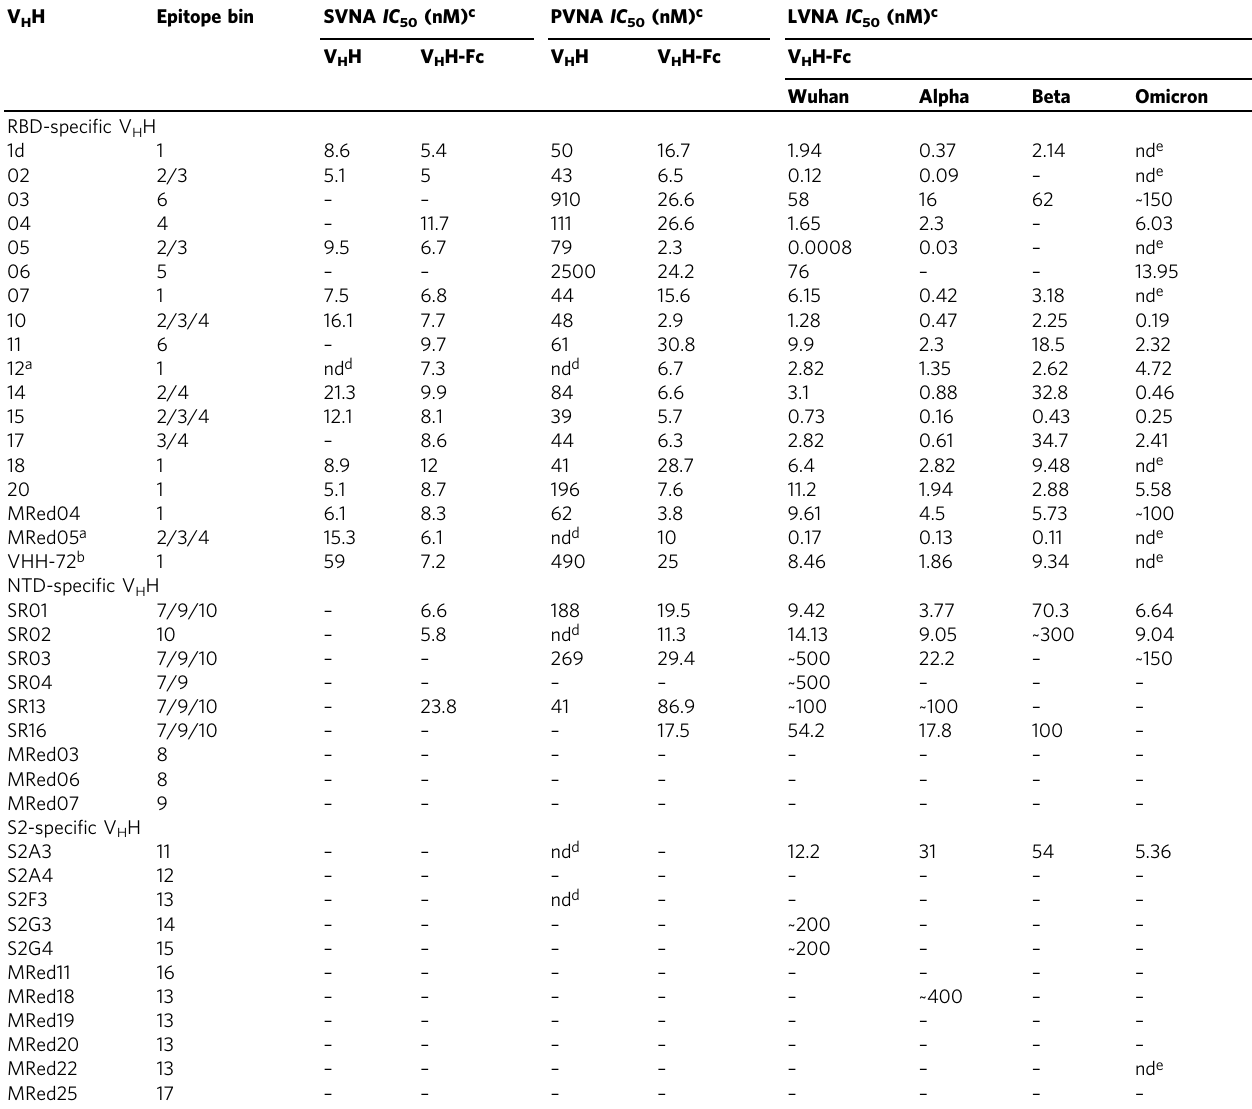
Table 2 Neutralization potencies of V H Hs against SARS-CoV-2 Wuhan and variants. V H H Epitope bin